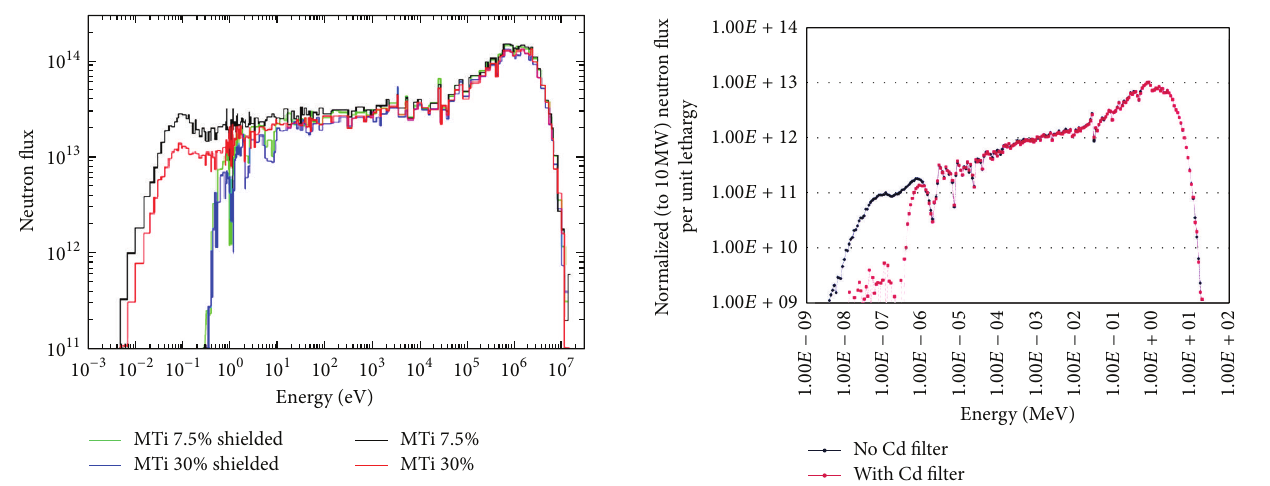
in a neutron screen. Hafnium is usually combined with aluminum, which is a good heat conductor and is transparent to fast neutrons.